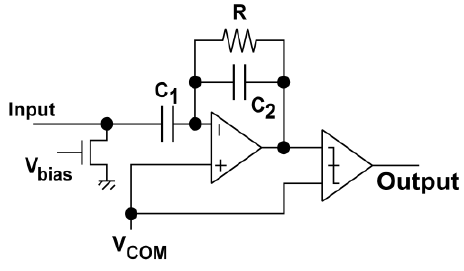
Figure 5. Bandpass amplifier and